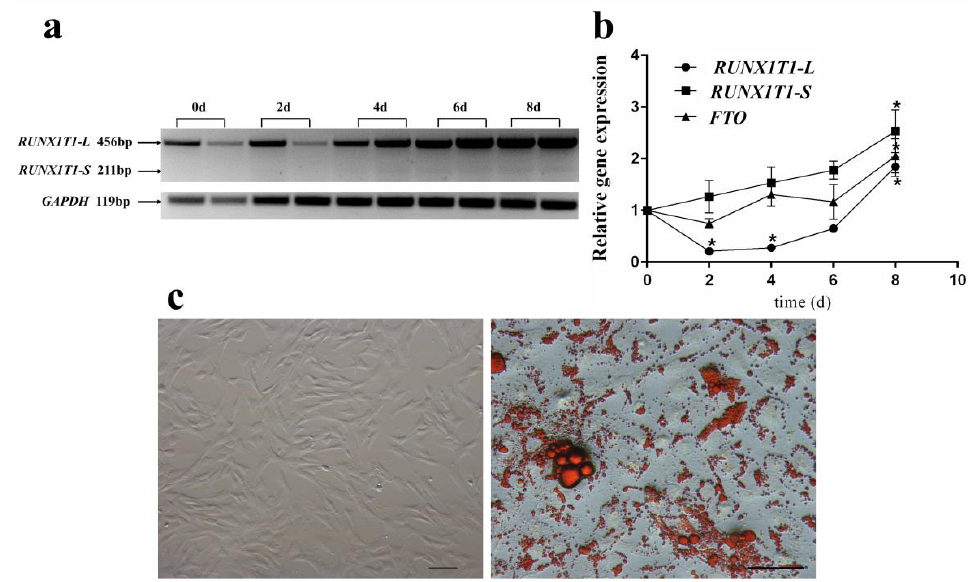
Figure 6. Expression patterns of RUNX1T1 isoforms during ovine preadipocyte differentiation. The temporal expression pattern of RUNX1T1 isoforms and FTO during ovine preadipocyte differentiation ( a , b ); image of newly isolated and adipogenic differentiated ovine preadipocytes ( c ). Scale bars = 100 µm. One-way ANOVA followed by comparison of all time points to day 0 with Tuckey post hoc analysis, * p < 0.05. Quantitative data are represented as the mean ± SEM ( n = 4).